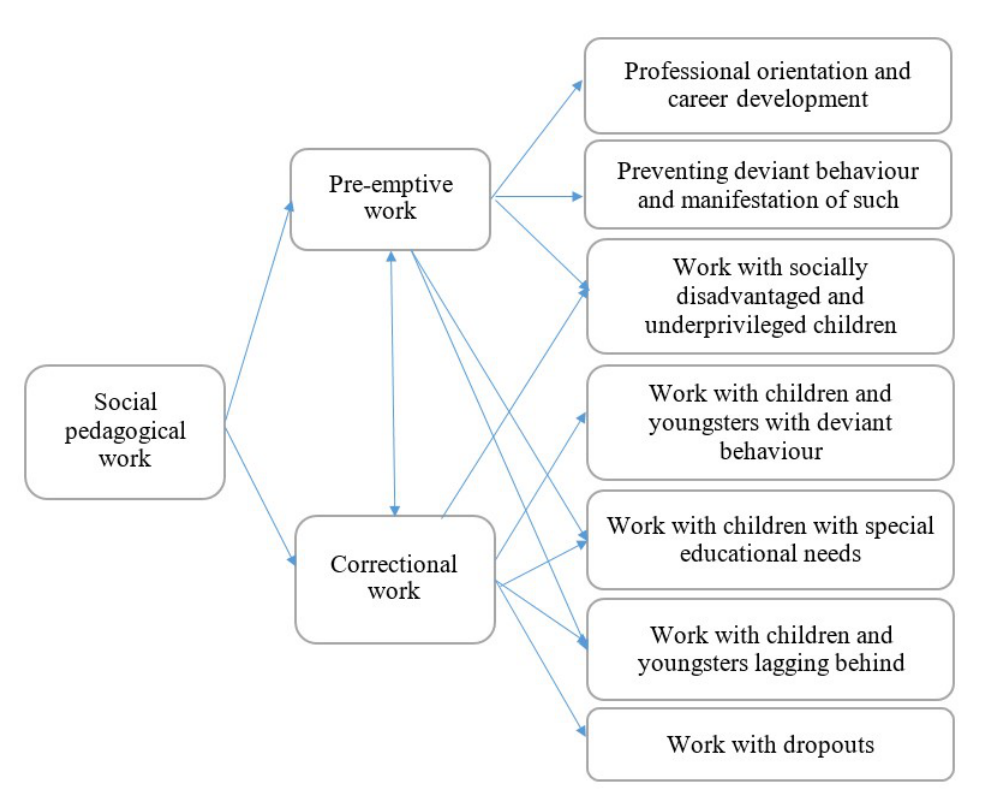
Figure 1. Social pedagogical work in school (Source: Author, 2021, based on Zdravkova,